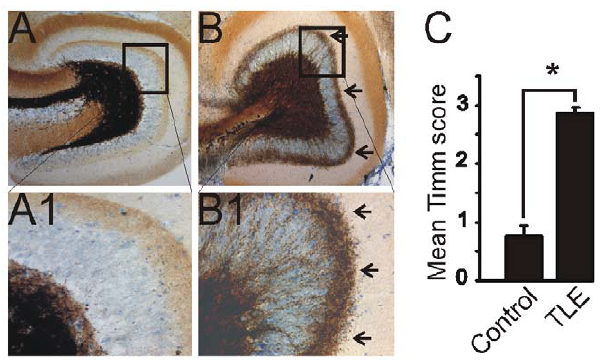
Figure 1. Timm stain illustrating mossy fiber sprouting into the dentate gyrus inner molecular layer in pilocarpine-treated mice. A. Dentate gyrus of a normal mouse. B. Dentate gyrus of a pilocarpine-treated mouse that survived status epilepticus (SE) showing mossy fiber sprouting. A1 and B1 are enlarged boxed regions of A and B . The arrows in B and B1 point to extensive mossy fiber sprouting into the inner molecular layer of the dentate gyrus. C. Graph showing the mean Timm score between controls and pilocarpine-treated mice that survived SE. Asterisk, significant difference between mean scores (P , 0.05).